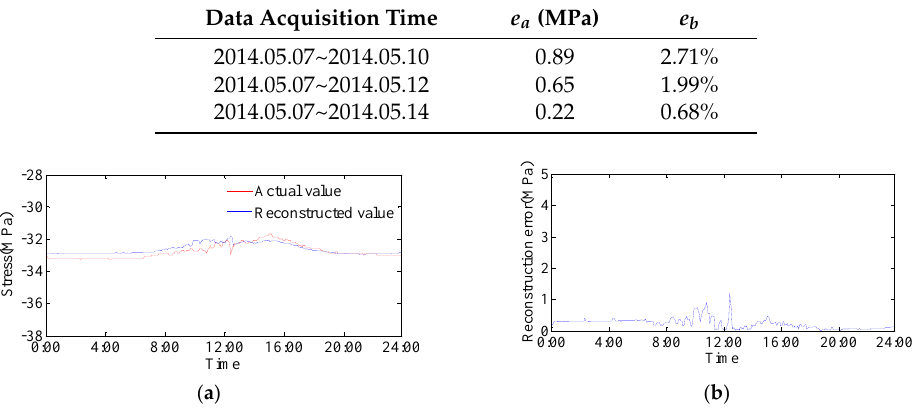
larger than the unknown coefficients is the basic requirement for regression function identification; The correlation model using stress monitoring data from 7 May 2014 to 14 May 2014 is: